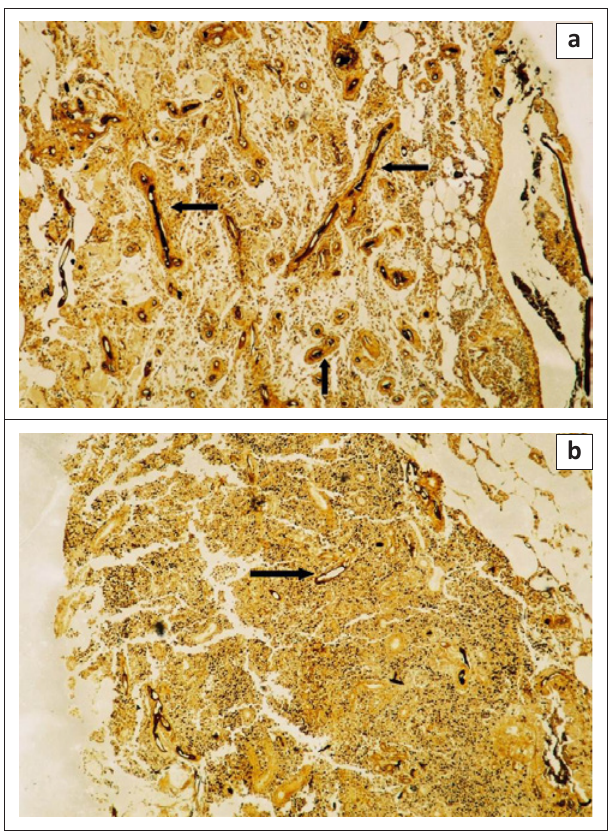
FIGURE 6: (a) Intense inflammation accompanying a progressing epizootic ulcerative syndrome lesion in Hydrocynus vittatus caught in the Okavango River near Shakawe during September 2010. (b) Deep ulceration typical of an advanced epizootic ulcerative syndrome lesion in Serranochromis robustus caught in the Okavango River below Popa Falls during July 2010.